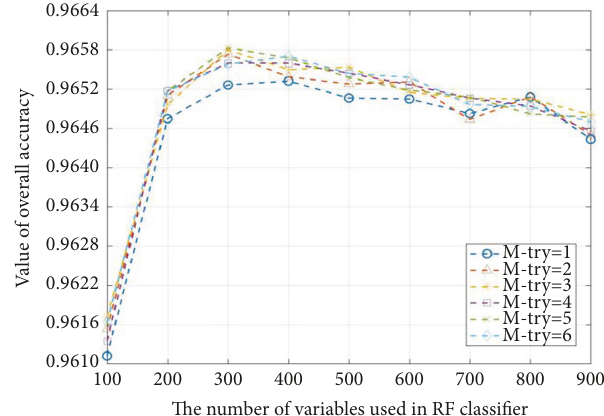
Figure 12: The tendencies of overall accuracy when the N tree and M try are setting different values for Hyperion.